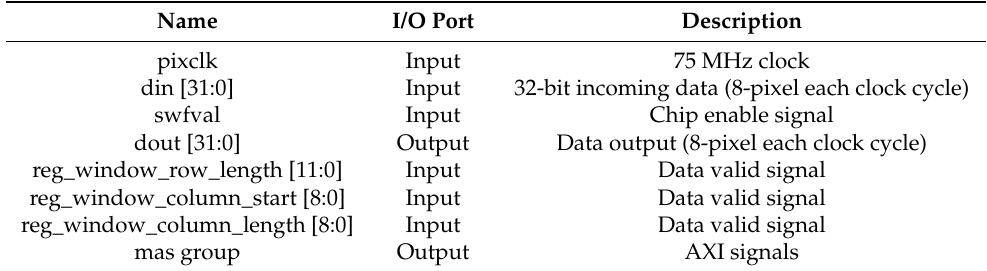
Figure 15. Interface of the implemented image_tx.vhd module. Table 6. Port description of the image_tx